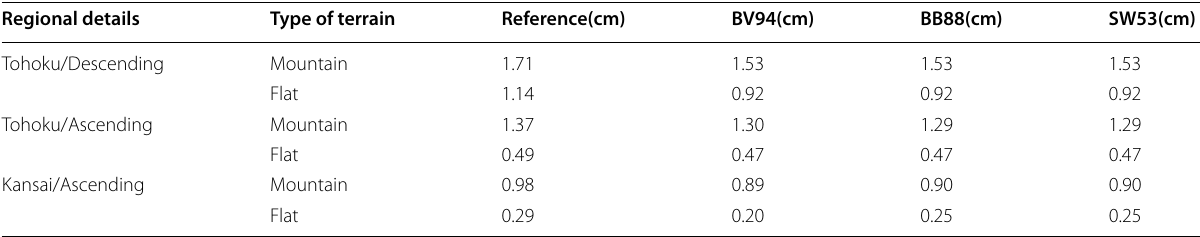
Table 4 Mean standard deviation of mountainous and flat areas in